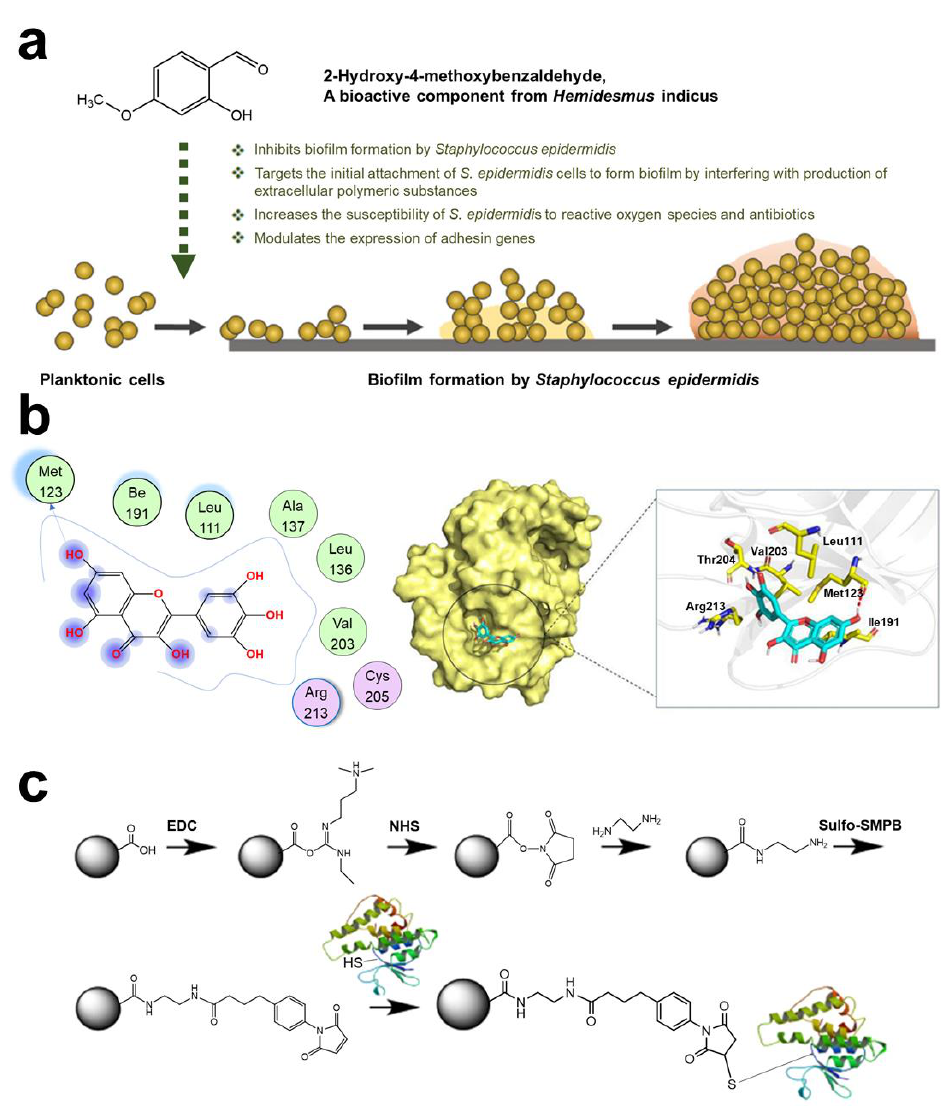
Figure 2. Schematic diagram of targeting adhesin strategy. ( a ) Mechanism of HMB targeting S.epidermidis . Reprinted with permission from Ref. [73]. Copyright 2020, Arumugam Veera Ravi. ( b ) Action sites of myricetin and SrtA . Reprinted from Ref. [74]. ( c ) Interaction mechanism between inhibitor MAM7 and Glutathione-S-Transferase (GST) fusion protein. Reprinted from Ref. [77].